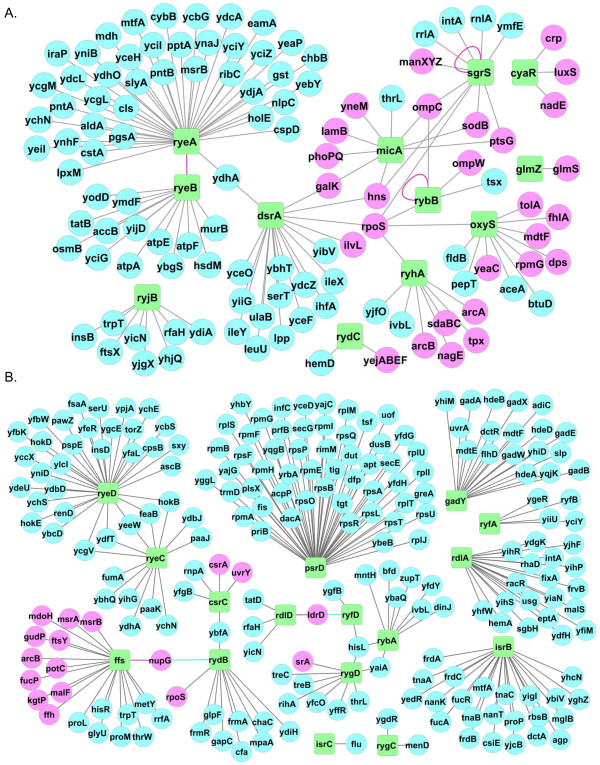
Network of YbeY-regulated sRNAs and targets. (A) shows the YbeY as well as Hfq-dependent sRNA target network; (B) represents the YbeY-dependent but Hfq-independent network respectively. Green squares are the differentially expressed sRNA in microarray analysis. Pink circles are experimentally validated targets and blue circles are CLR inferred targets that are significantly regulated in microarray analysis. Differential expression of sRNAs and target genes were determined from microarray experiments and sRNA-target interactions were determined using the strategy described in Methods and summarized Figure 2.